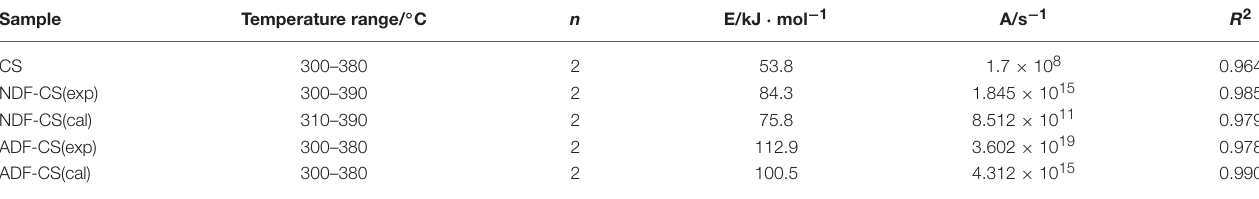
TABLE 5 | Pyrolysis kinetics parameters of CS and its detergent fibers.